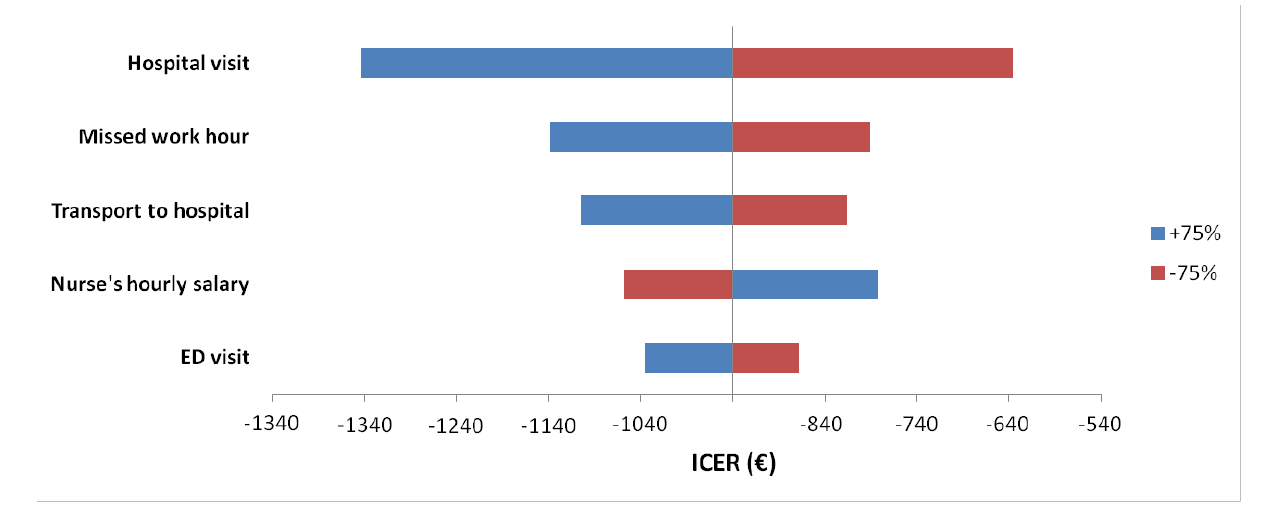
Figure 2. Tornado diagram showing the impact of cost parameters on ICER.